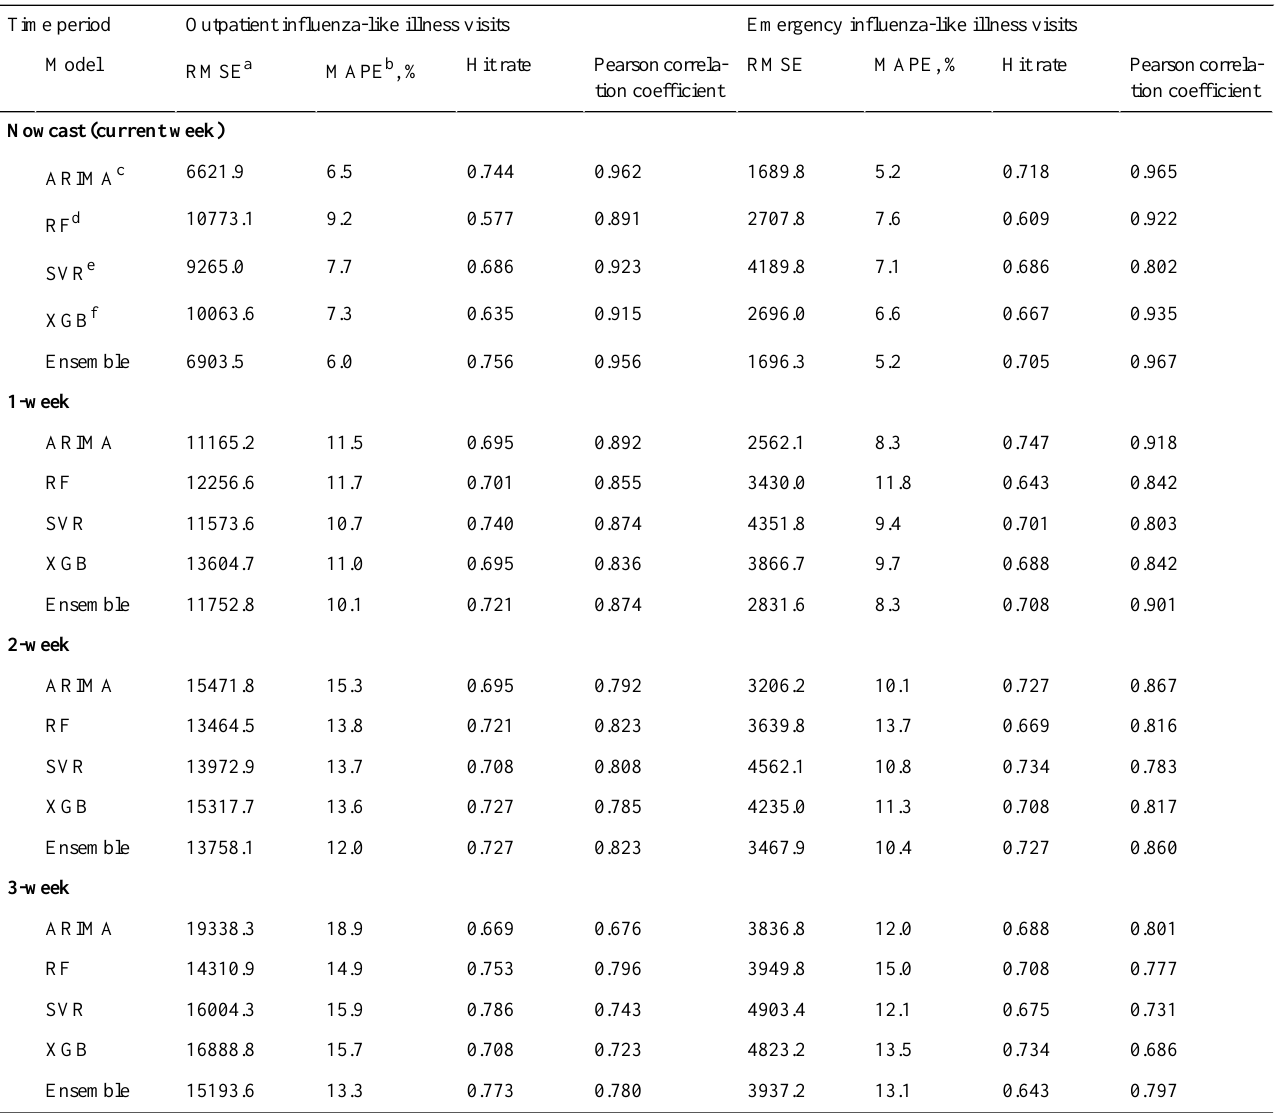
Table 1. The evaluation metrics of the 5 machine learning models for then-current week forecasts (nowcast), 1-week forecasts, 2-week forecasts, and 3-week forecasts for 2015 to 2017